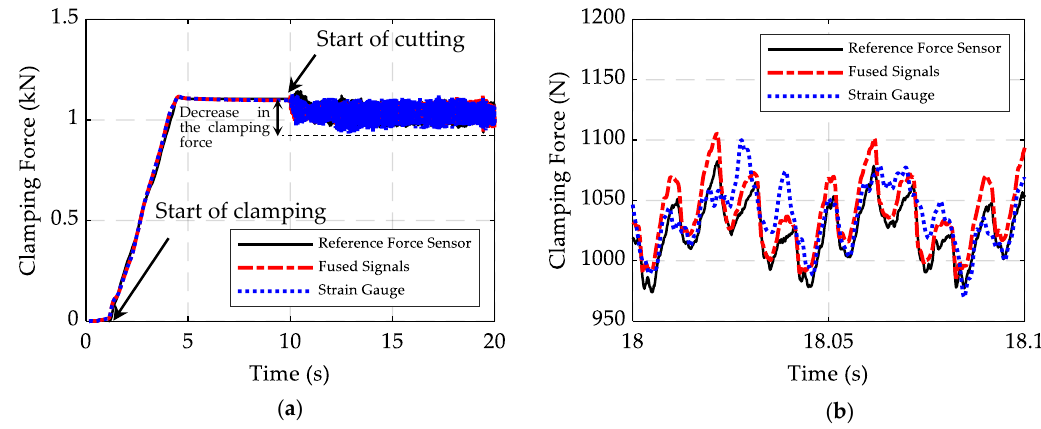
Figure 21. Comparing the measured forces: ( a ) from the start of clamping followed by cutting; ( b ) at the cutting